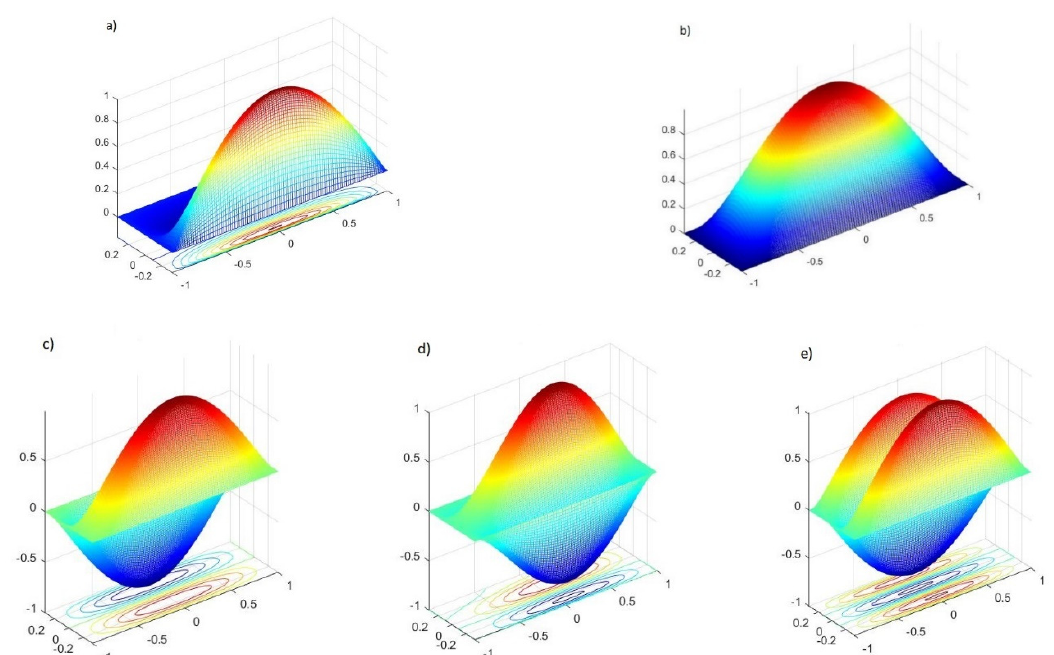
Figure 16. Vibrational modes for the USFG distribution with η = 1 and µ = 0.25: ( a ) 1st mode, ( b ) 2nd mode, ( c ) 3rd mode, ( d ) 4th mode, ( e ) 5th mode.